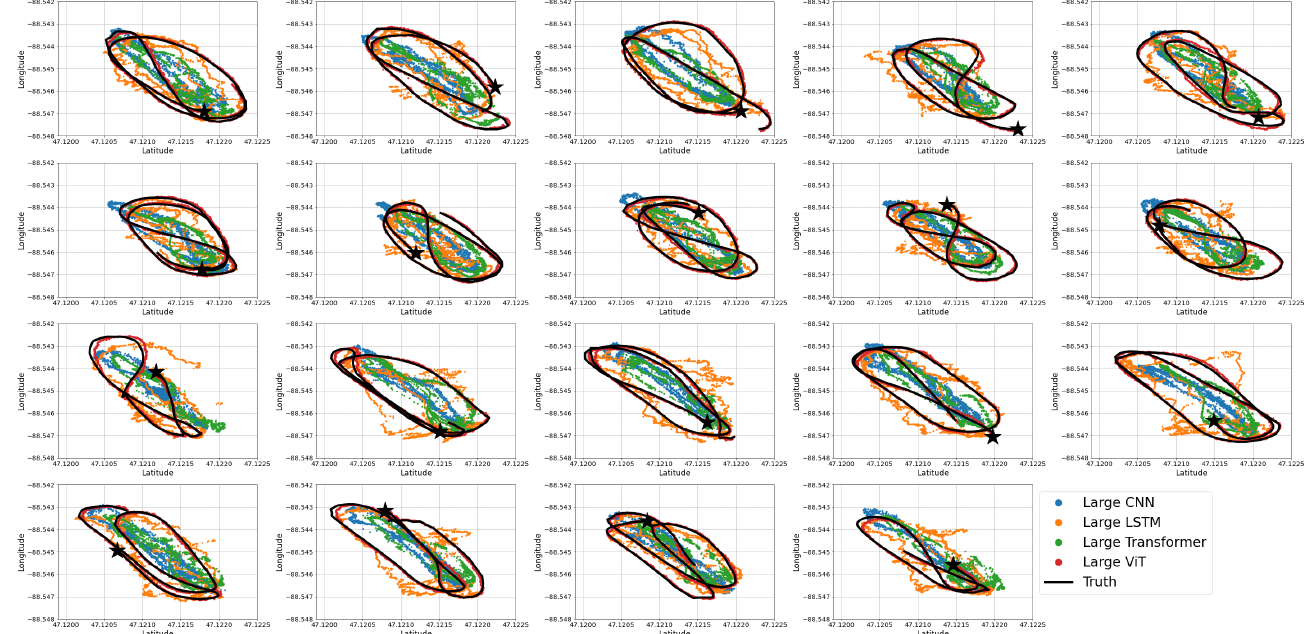
Figure A1. All of the test data using large regression networks where the star indicates the start of the each